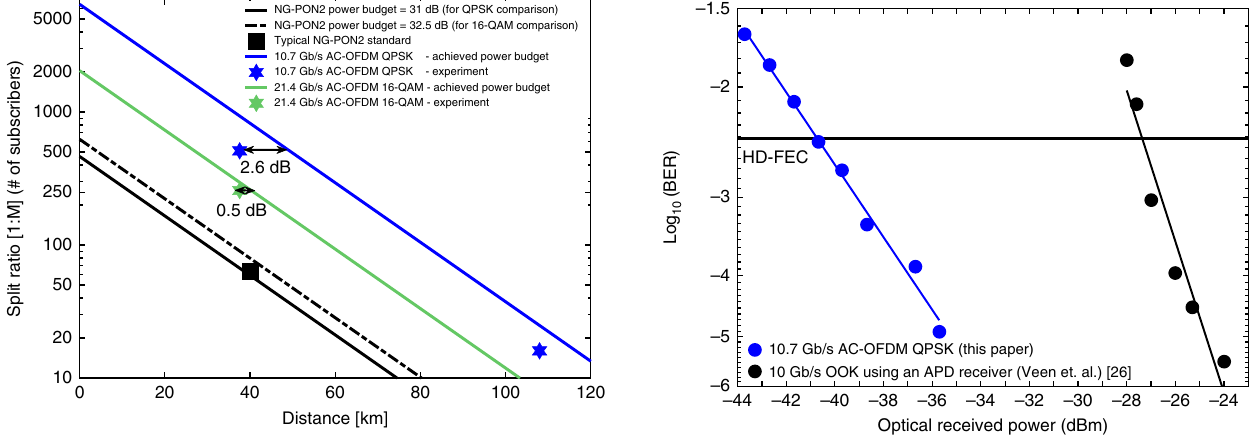
Fig. 8 Performance comparison of our PI coherent receiver and a direct detection (APD) receiver. BER vs optical received power for 10.7 Gb/s Alamouti-coded OFDM QPSK received using the PI coherent receiver (demonstrated in this article) and 10 Gb/s TDM-OOK received using a direct-detection (APD) receiver (demonstrated by Veen et al.)